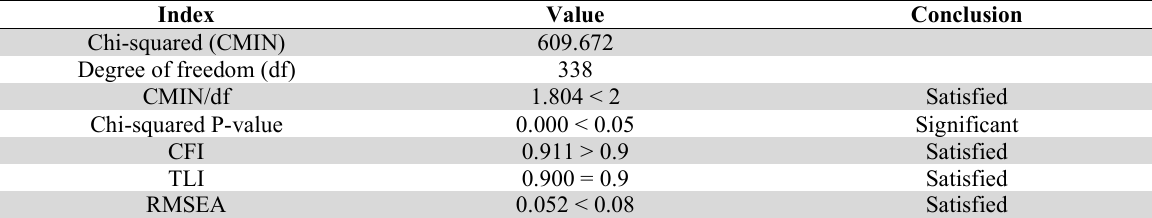
Model fit summary